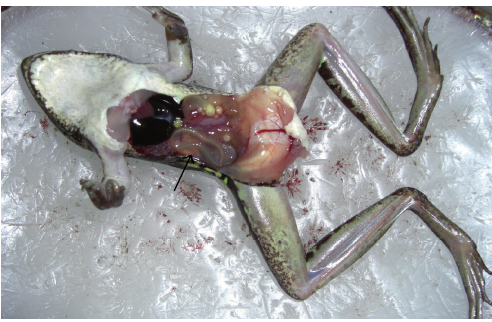
Figure 3: Showing the encysted ascaridoid larva in the body cavity of a Ptychadena